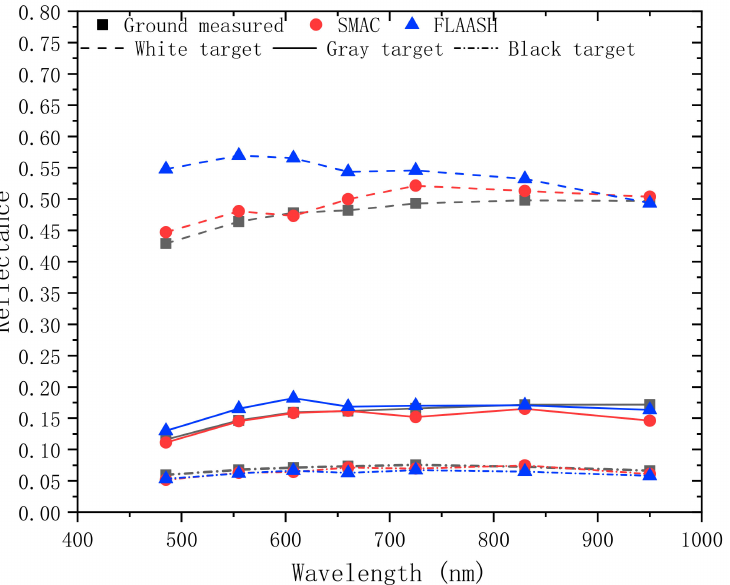
Figure 19. The average surface reflectance of white, gray, and black targets in the corrected image of